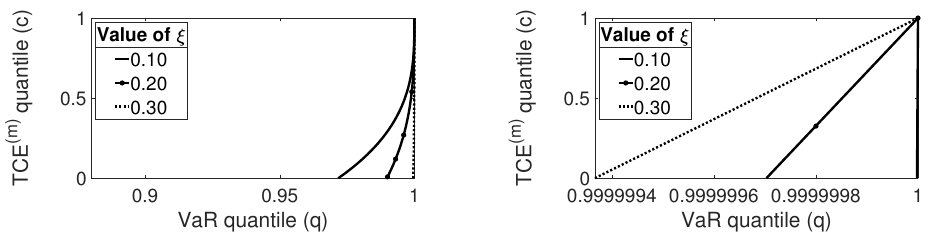
Figure 3. Extended TCE quantile as a function of VaR quantile. ( Left panel ): m = 3 and θ = 1. ( Right panel ): m = 3 and θ =